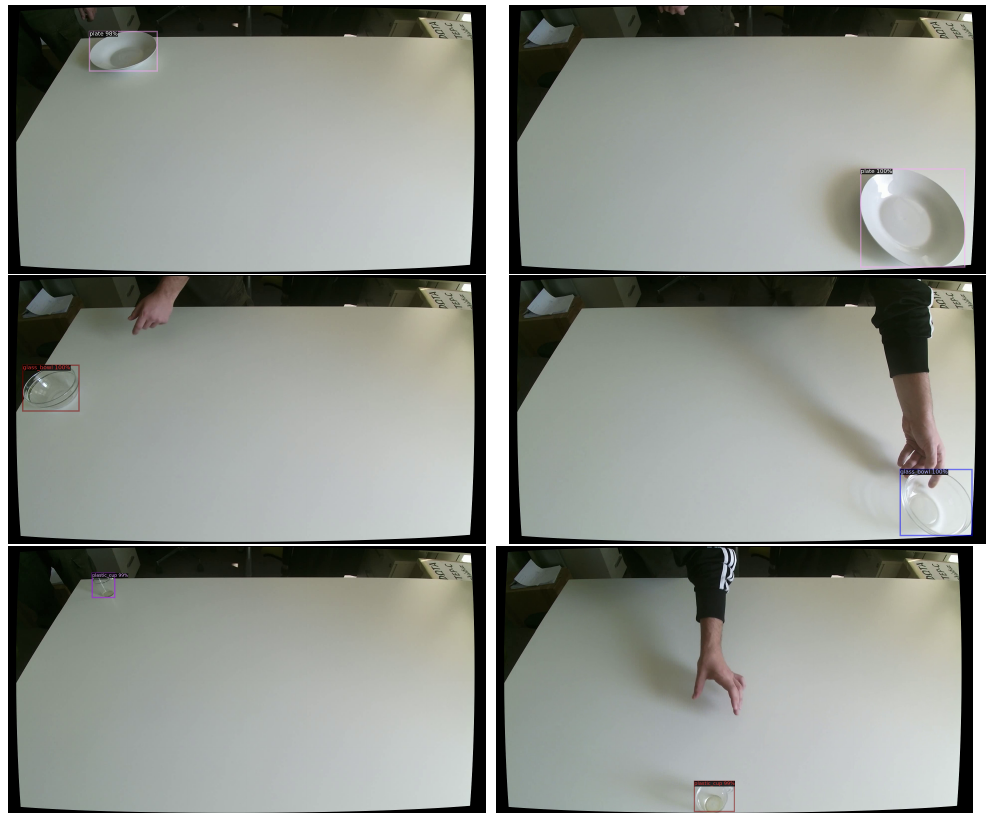
Figure 17. Performance of the custom detector in the same three classes: successfully annotated instances of the custom